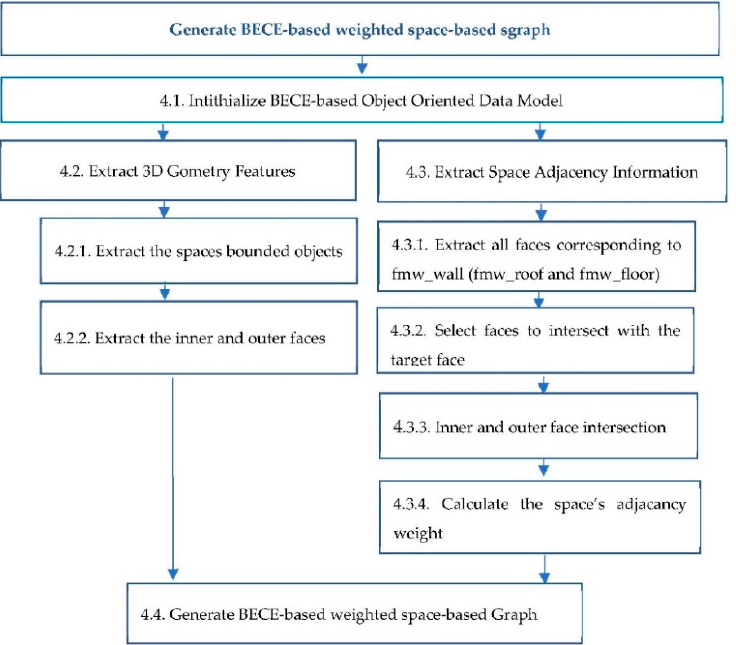
Figure 4. The workflow of generating a BECE-weighted space-based graph.